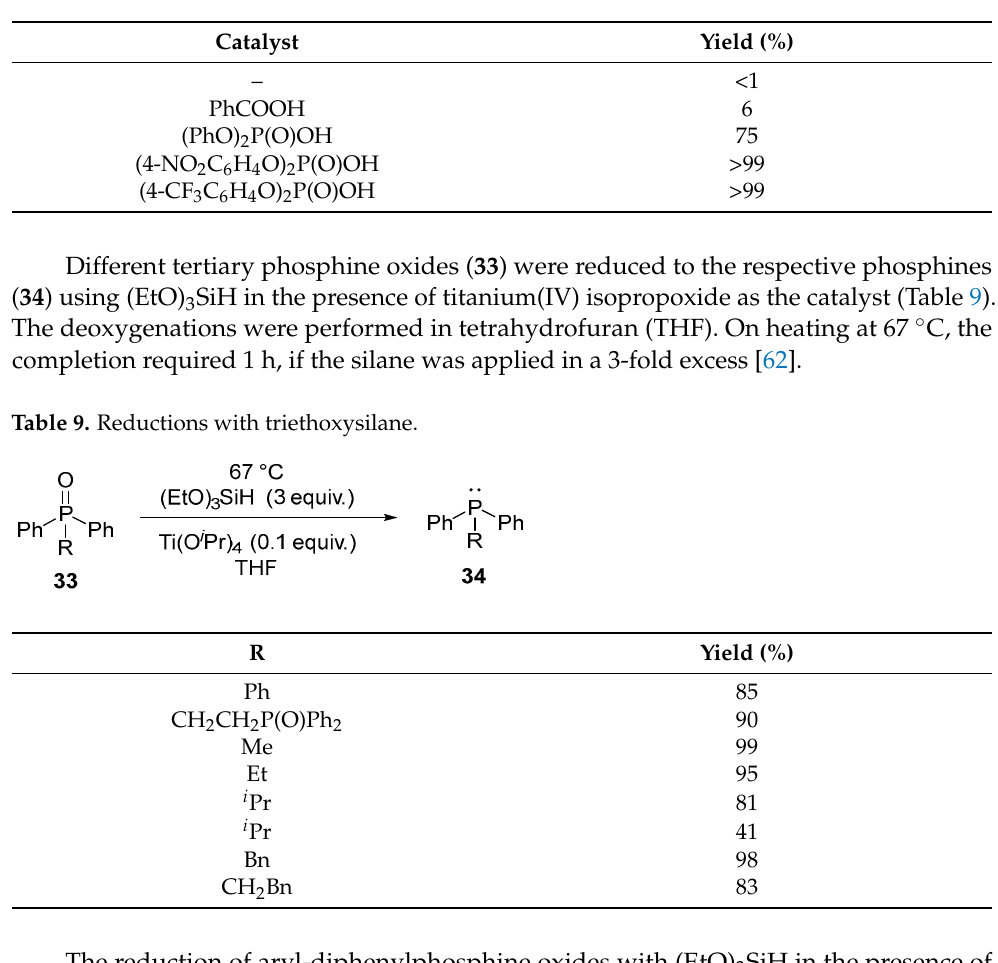
Table 10. The catalytic deoxygenation of triphenylphosphine oxide ( 31 ) applying 1,1,3,3 ‐ tetrame ‐ thyldisiloxane (TMDS) as the reducing agent.